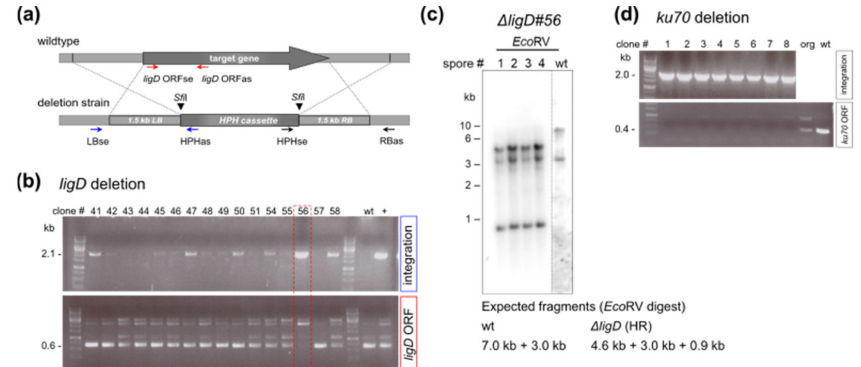
Figure 1. Generation of ligD and ku70 deletion mutants in C. thermophilum . ( a ) Schematic representa- tion of the linear PCR product used for transformation and integration of the hygromycin resistance cassette into the target gene locus via homologous regions. Arrows depict oligonucleotides used for PCR analysis. ( b ) PCR analysis performed on gDNA isolated from individual HPH-resistant ∆ ligD transformants to verify in locus integration events. A marker-specific oligonucleotide and an oligonucleotide designed to anneal outside the homologous region flanking the HPH-cassette were used and only those clones that underwent a correct recombination event would produce an amplicon of the designated size of 2.1 kb (upper panel). Conversely, a set of oligonucleotides annealing inside the ligD open reading frame is not expected to result in an amplicon in case of a gene replacement event, whereas a 0.6 kb fragment is expected from the wild-type ligD allele (lower panel). Wild-type gDNA was included as negative control. gDNA isolated from a heterokaryotic clone from a previous transformation served as positive control for the PCR reaction. ( c ) Southern analysis confirming the deletion of ligD . A combination of left and right homologous flanking regions was used as probe and the expected fragments for the wild-type, and the strains undergoing homologous integration events with the HPH-resistance cassette in the ligD locus, respectively, are indicated below. ( d ) PCR analysis to verify ku70 deletion was performed as described in ( b